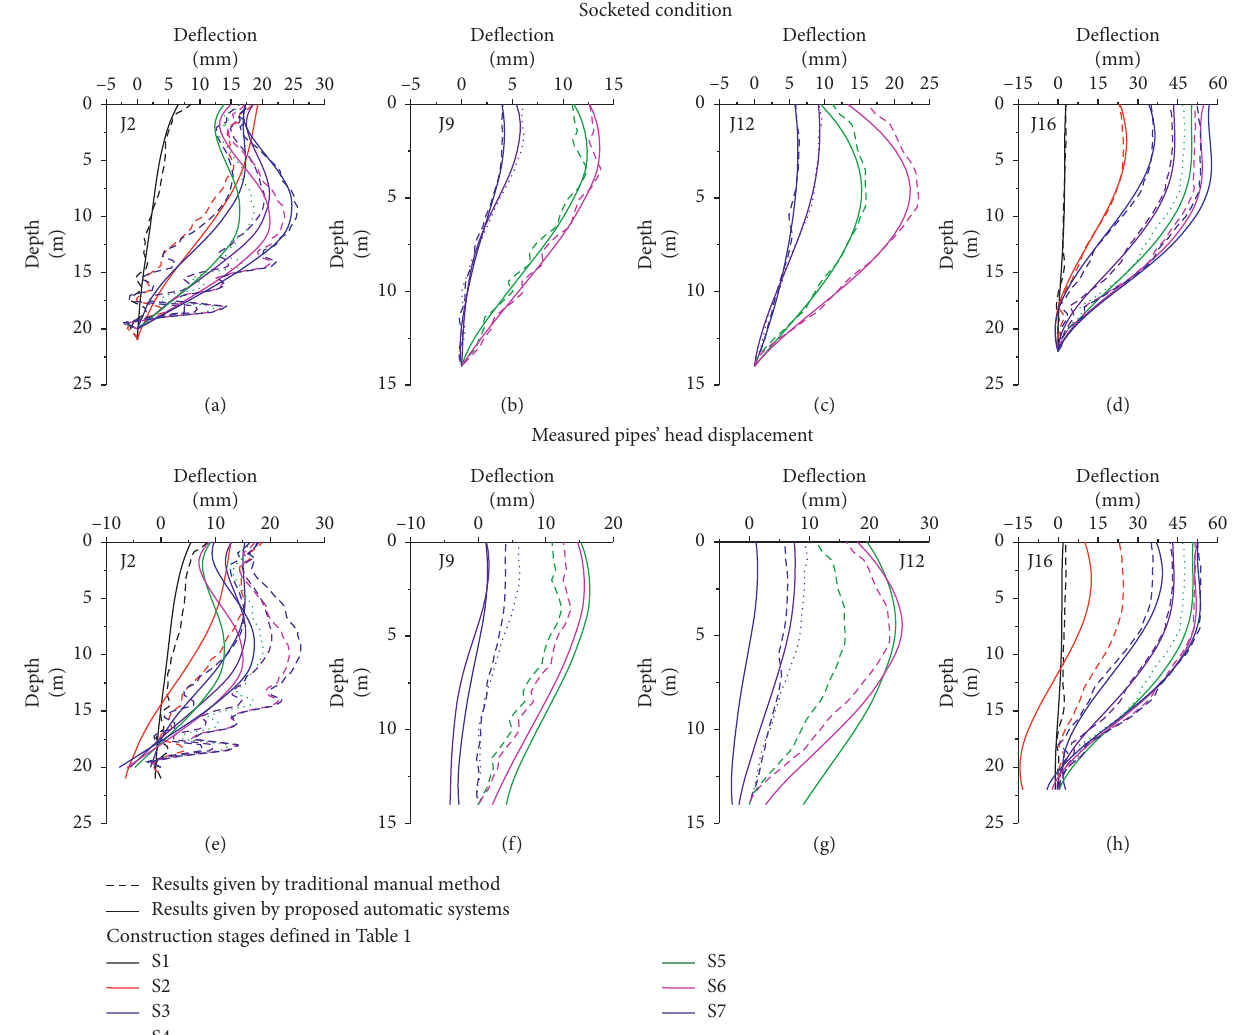
Figure 10: Comparison of the monitored results between the proposed automated system and traditional manual method at several typical construction stages in the studied